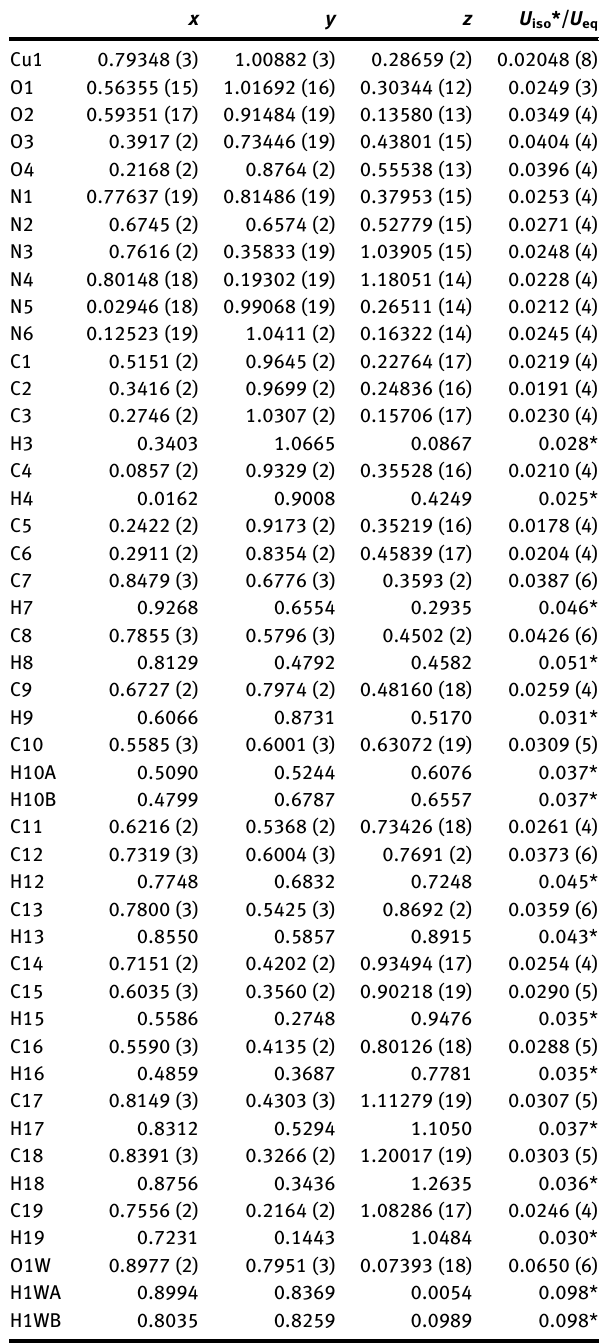
Table  : Fractional atomic coordinates and isotropic or equivalent isotropic displacement parameters (Å 